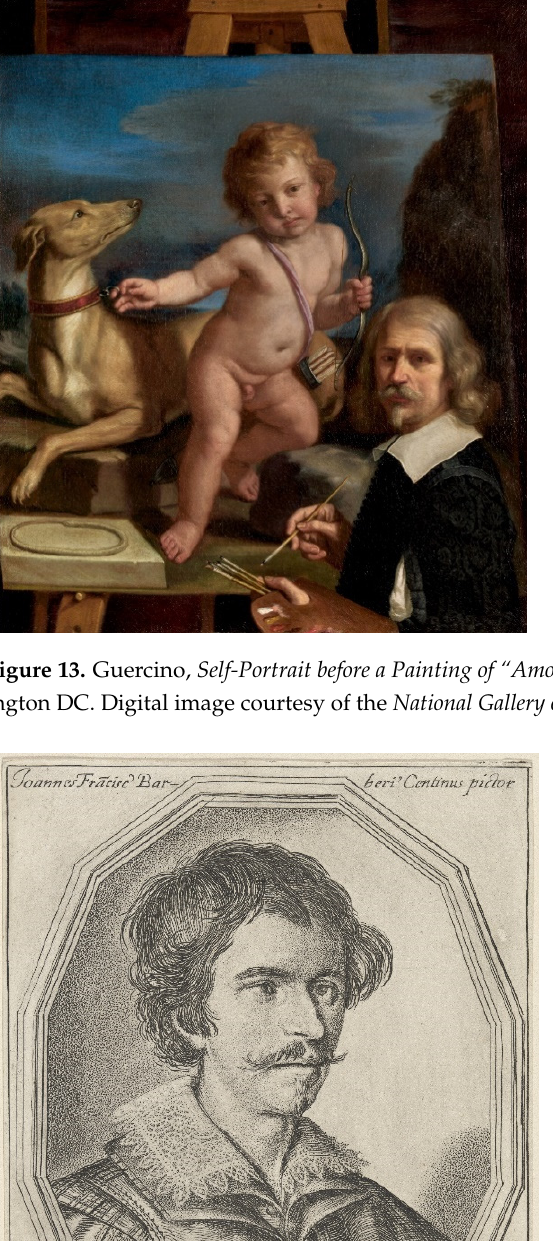
Figure 12. Guercino, Self-Portrait , 1635/40, London, Schoeppler Collection. Photo: Wikiart, Public Domain.